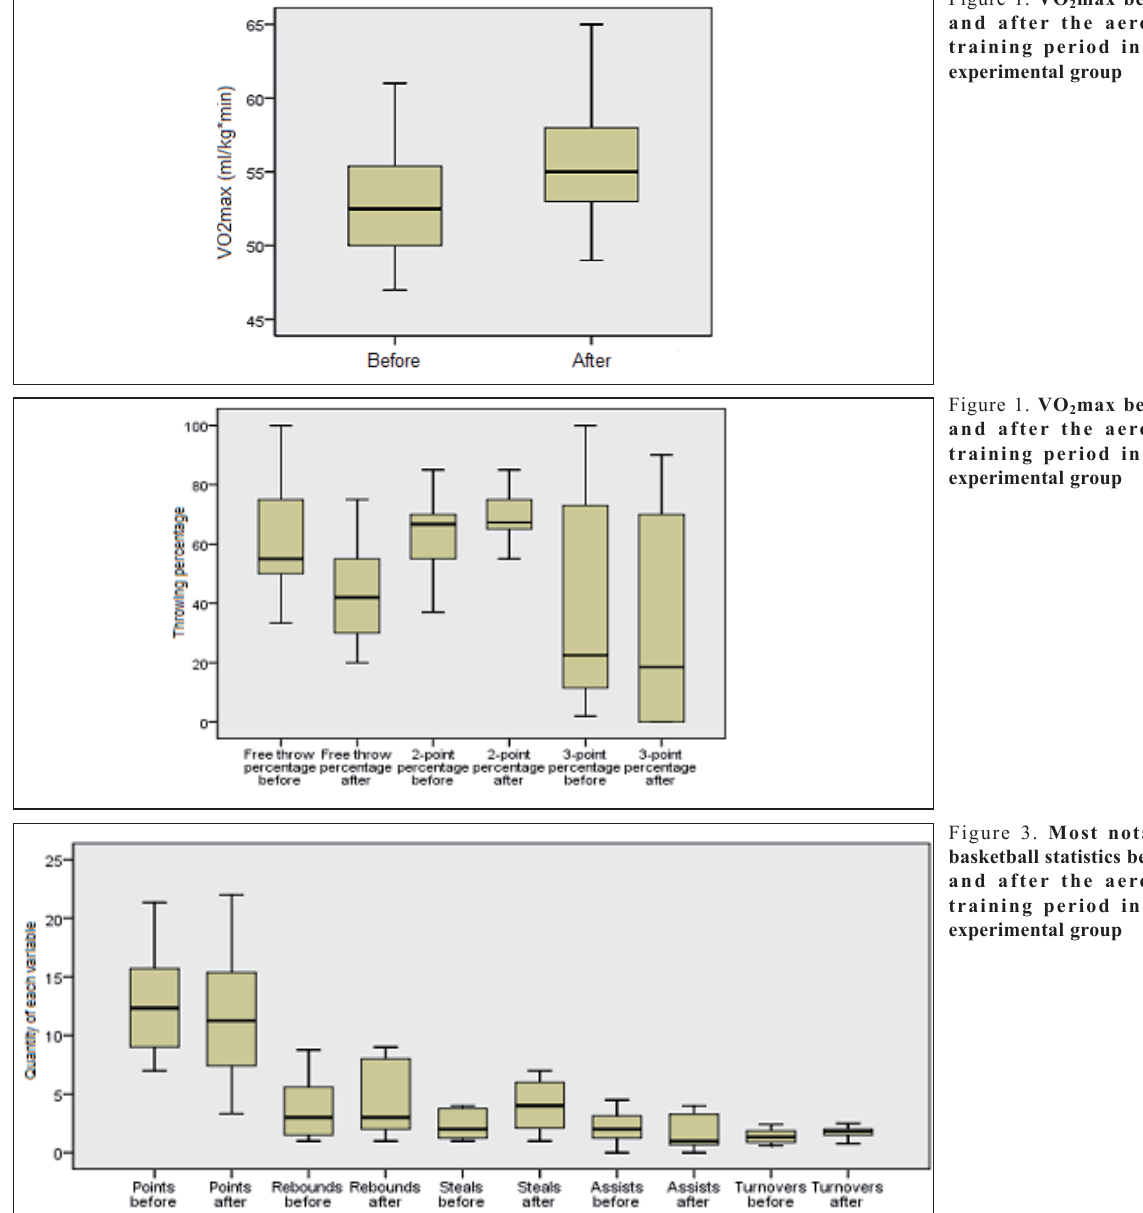
Figure 3. Most notable basketball statistics before and after the aerobic training period in the experimental